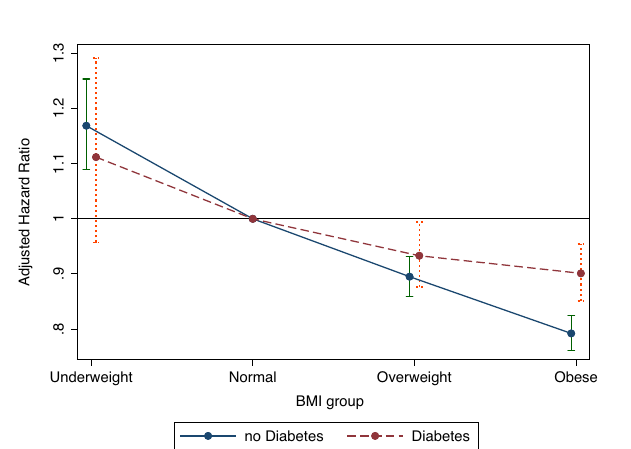
Figure 2. The cumulative adjusted hazard ratio of Alzheimer disease by late-life body mass index categories for 10 years.